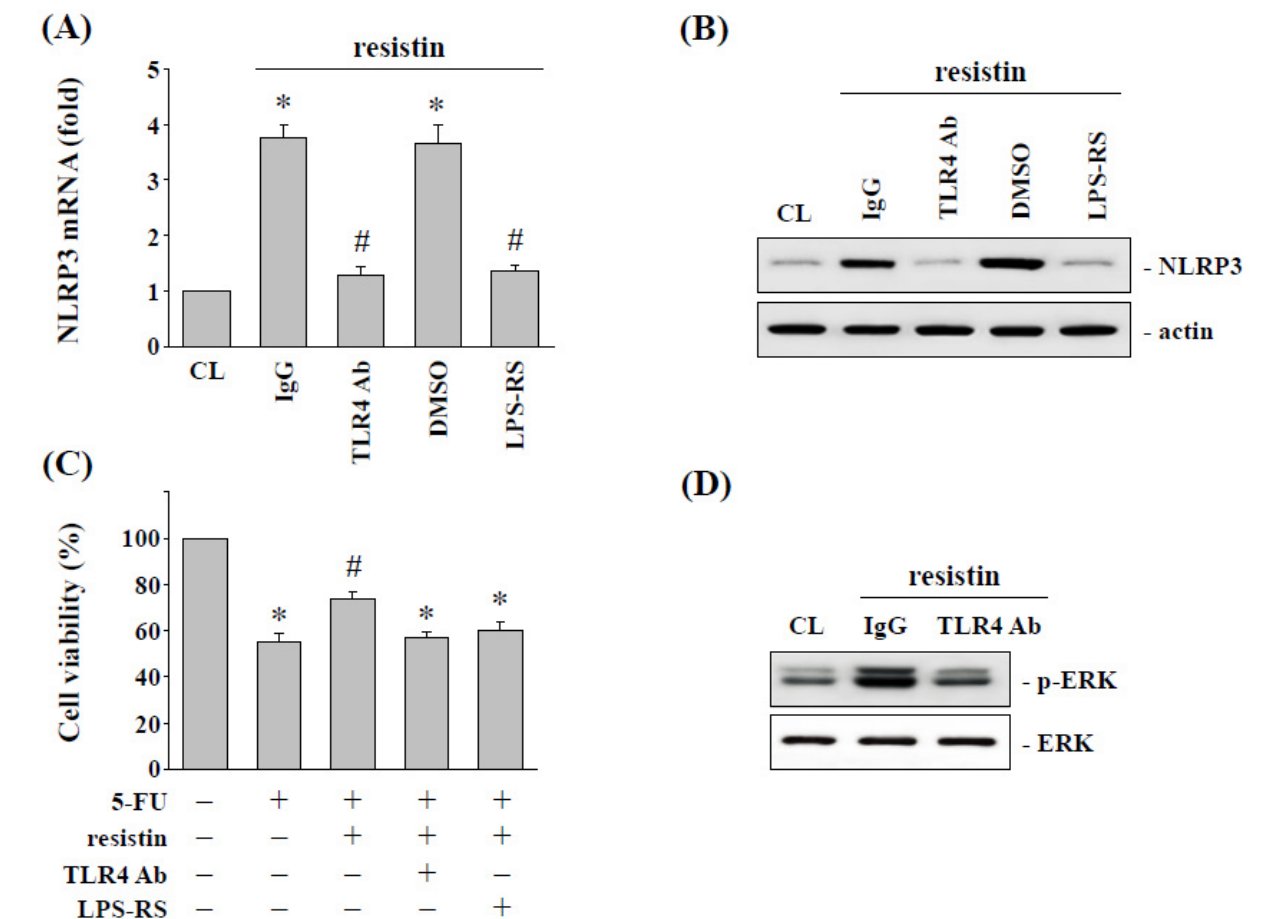
Figure 5. TLR4 signaling regulates resistin-activated NLRP3 expression in HCT-116 cells. ( A – C ) HCT-116 cells were kept as the control (CL) or treated with resistin for 12 h, then cultured in 5-FU for a further 48 h. After being treated with resistin, HCT-116 cells were pretreated with a neutraliz- ing antibody for TLR4 (Ab-TLR4) or a specific inhibitor for TLR4 (LPS-RS) and then treated with 5- FU. ( A ) The mRNA expression of NLRP3 was determined by real-time PCR. ( B ) The protein expres- sion of NLRP3 was determined by Western blotting. ( C ) Cell viability was assayed using the MTS assays. ( D ) HCT-116 cells were kept as the control (CL) or treated with resistin for 1 h. Before being treated with resistin, HCT-116 cells were pretreated with a neutralizing antibody for TLR4 (Ab- TLR4). The ERK phosphorylation was determined by Western blotting. Data in ( A , C ) are shown as mean ± SEM from three independent experiments. * p < 0.05 versus CL. # p < 0.05 versus DMSO/5- FU-treated cells. Results in ( B , D ) are representative of three independent experiments with similar results.